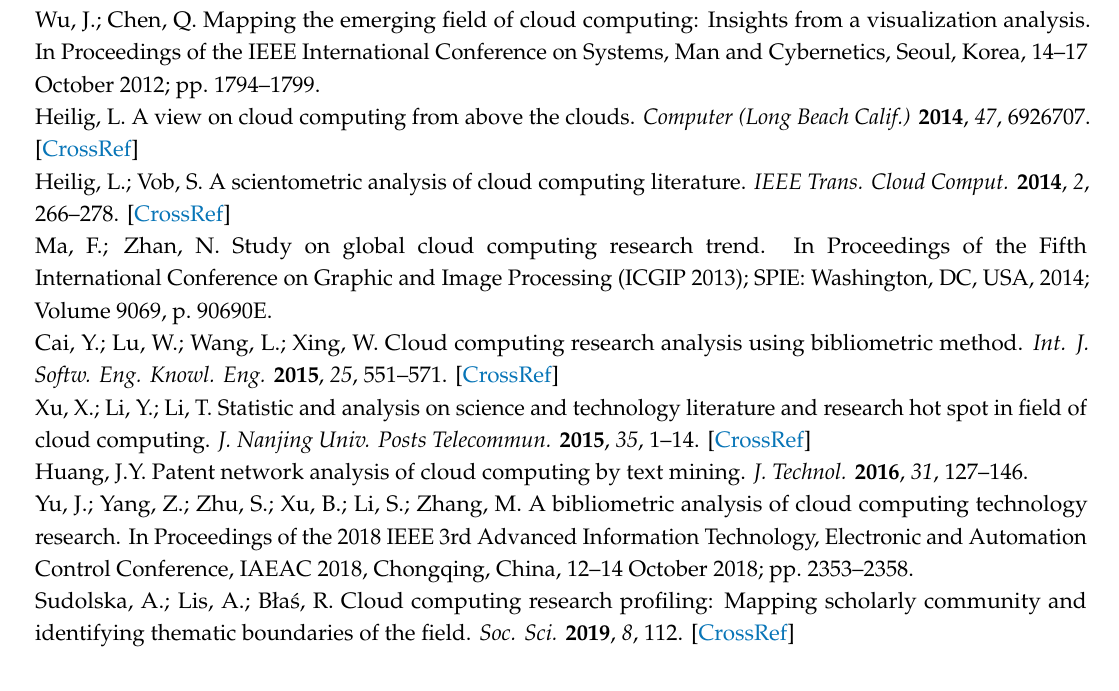
Supplementary Materials: Table S1: Reference list and key research findings (2009–2015); Table S2: Reference list and key research findings (2016–2020) are available at http: // www.mdpi.com / 1996-1073 / 13 / 16 / 4117 /